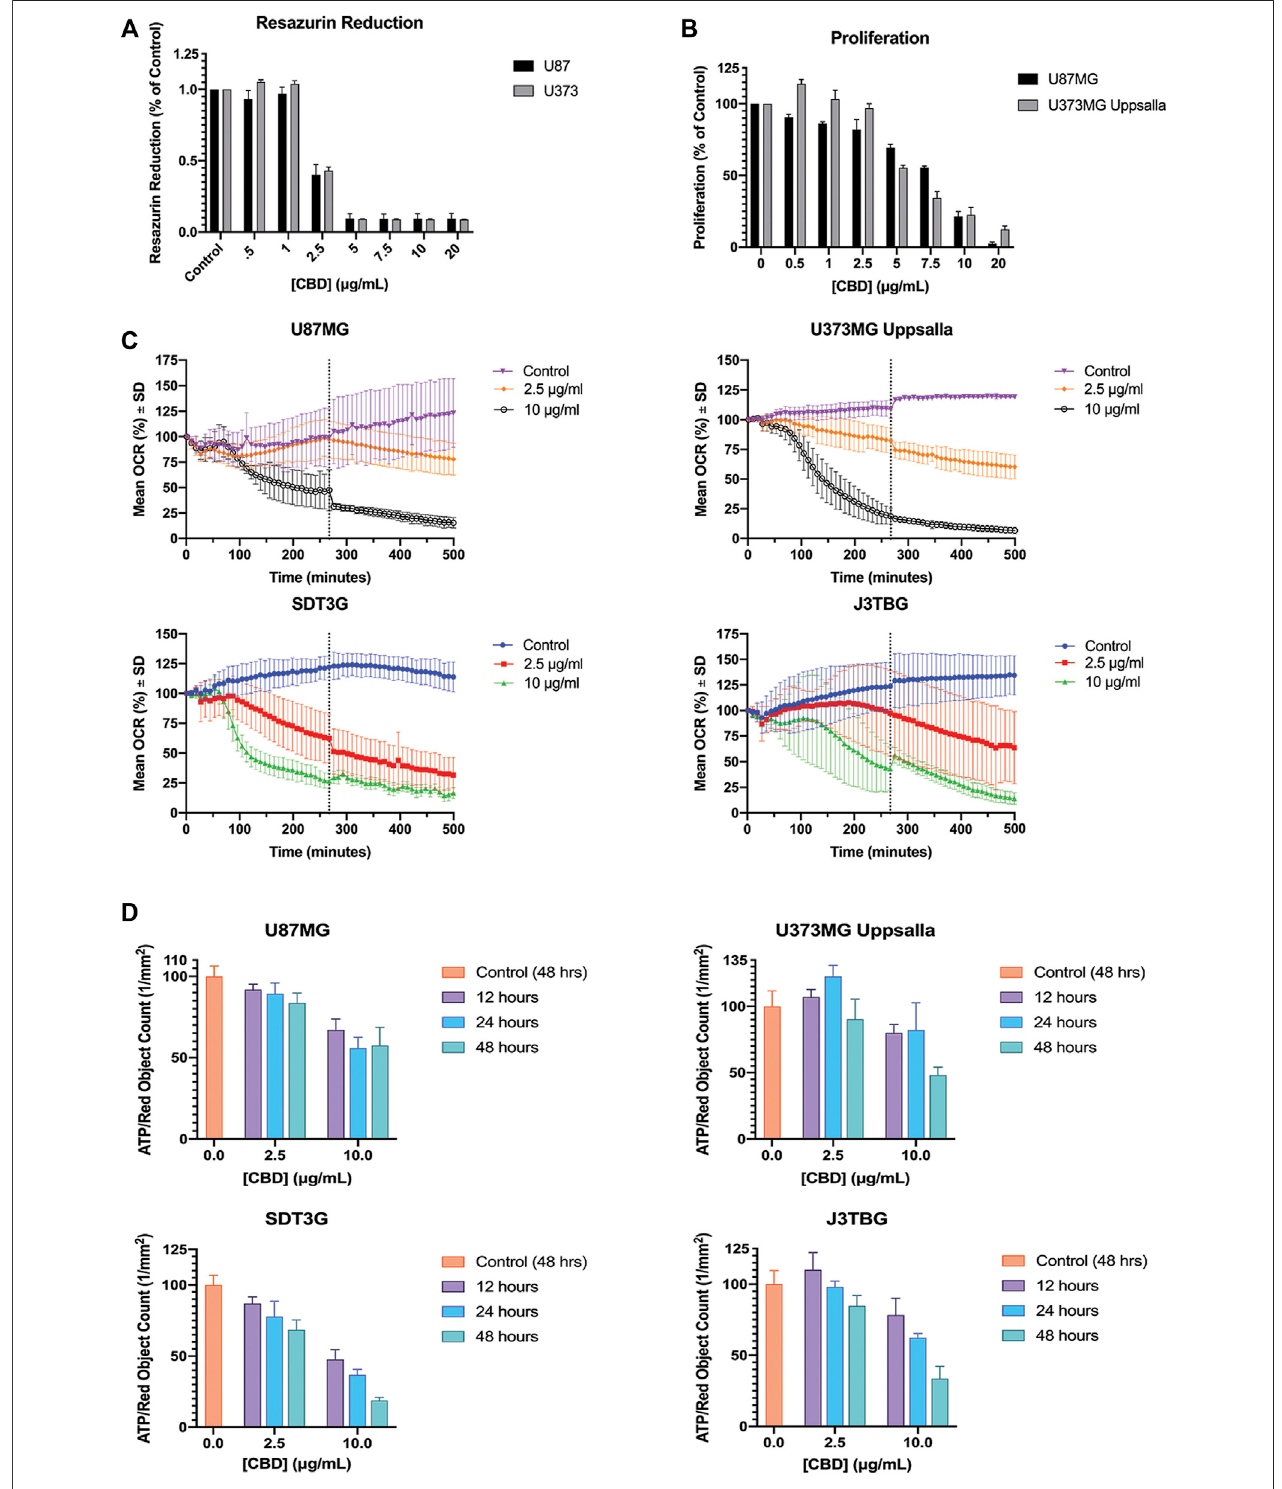
FIGURE3| CBDperturbsmitochondrialactivityatlethalandnon-lethalconcentrations. (A) GliomacelllinesU87MGandU373MGUppsalaweretreatedwithCBD isolate(0 – 20 ug/mL)for96 h.Cellviabilitywasdetermined via resazurin-basedmetabolicassay.Data(arbitrary fl uorescenceunits)werenormalizedtothevehicletreated control. Representative of n (cid:1) 3 independent experiments, expressed as mean ± SD. (B) Glioma cell lines U87MG and U373MG Uppsala were treated with CBD isolate (0 – 20 μ g/ml) for 96 h. Cell proliferation was measured via IncuCyte ™ Red Object Count. Data shown are from n (cid:1) 3 independently repeated experiments,